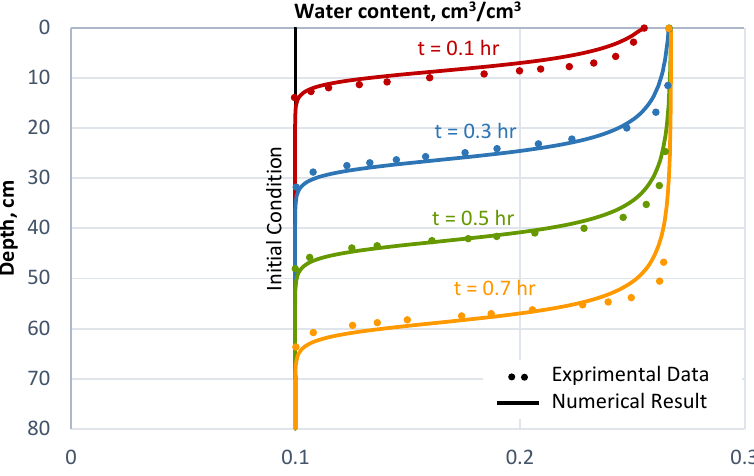
Figure 11. The result of hydrology module for one-dimensional infiltration problem.